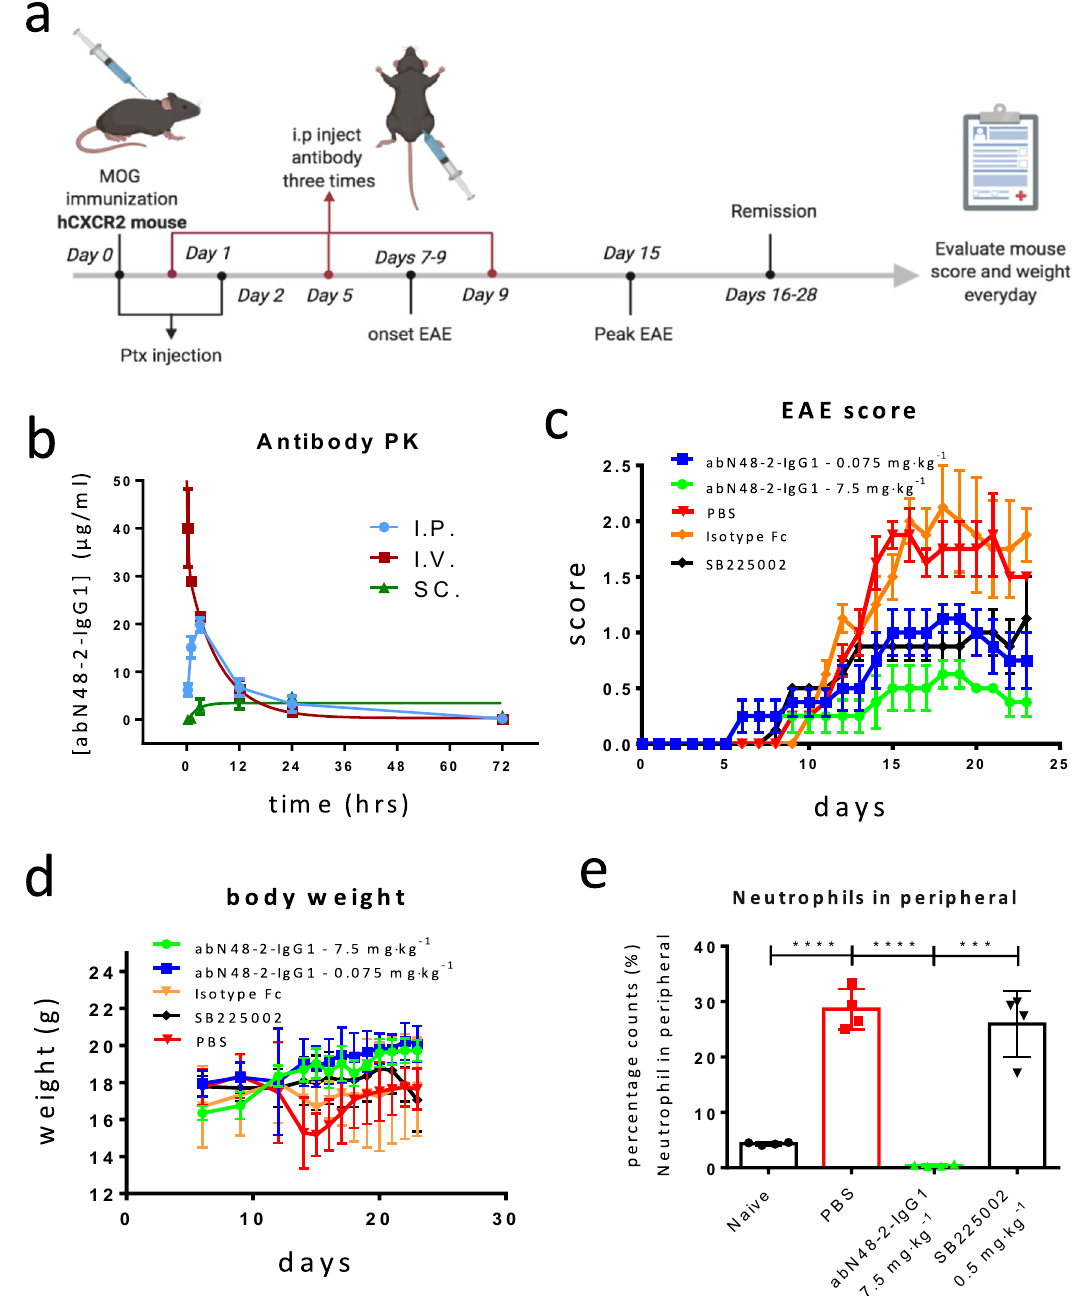
Fig. 5 Alleviation of EAE symptoms in h CXCR2 knock-in mice by abN48-2-IgG1. a Schematic illustration of abN48-2-IgG1 treatment in an EAE mouse model. b Result of PK study of abN48-2-IgG1 in h CXCR2 knock-in mice ( n = 4 mice per group). c , d EAE score and body weight of h CXCR2 knock-in mice during abN48-2-IgG1 treatment ( n = 4 mice per group). e Comparison of neutrophils in peripheral blood of experimental mice. One blood sample was collected from each mouse in the indicated groups: “ Naive ” represents the group ( n = 4 mice) without EAE stimulation; “ isotype Fc ” represents the group ( n = 4 mice) treated with negative control (Fc); “ PBS ” represents the group ( n = 4 mice) with EAE stimulation and PBS treatment; and “ abN48-2-IgG1 ” represents the group ( n = 4 mice) with EAE stimulation and abN48-2-IgG1 treatment (7.5 mg kg − 1 ). “ SB225002 ” represents the group ( n = 4 mice) with EAE stimulation and daily treatment with CXCR2-selective inhibitor SB225002 (0.5 mg kg -1 ). For panel b to d , data are presented as mean (center) ± s.d. (error bars). For panel e , data are presented as dots overlapped with mean (column) ± s.d. (error bars). Two-tailed t-test was employed for the signi fi cance of differences. p < 0.0001 ( p < 0.0001, ****) for t-test of “ PBS ” vs . “ Naive ” and “ abN48-2-IgG1 ” vs . “ PBS ” , p = 0.0001 ( p < 0.001, ***) for t-test of “ abN48- 2-IgG1 ” vs . “ SB225002 ” . t-values and degree of freedom were referred to the “ Methods ”